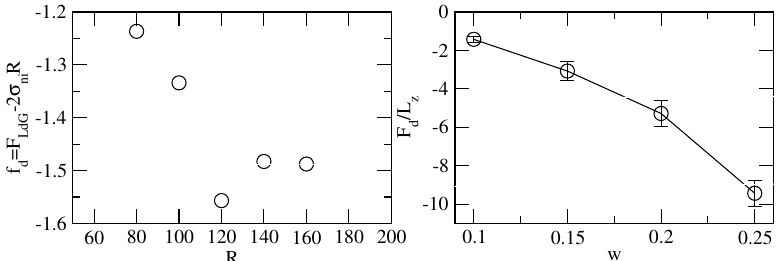
Figure A5. ( Left ) Plot of F LdG / L z − 2 σ sn R as a function of R for interfacial nematic–isotropic configurations in contact with a substrate with anchoring strength w = 0.10. ( Right ) Plot of F d / L z as a function of w .